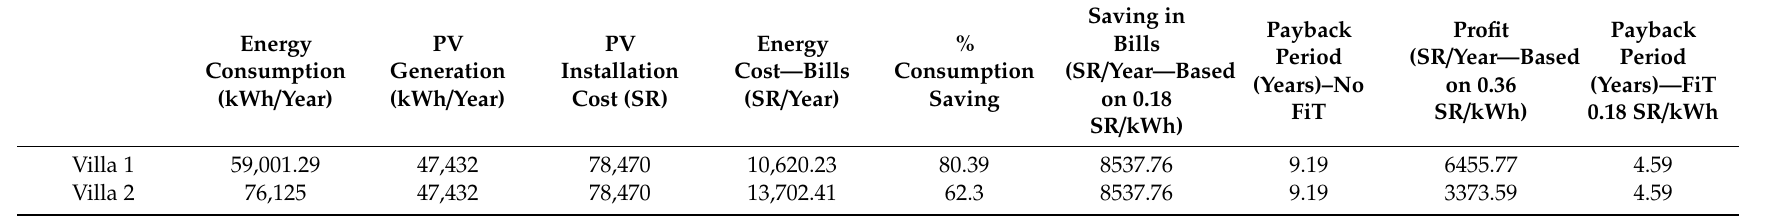
Table 6. Summary for the generated energy, cost, and the payback period in